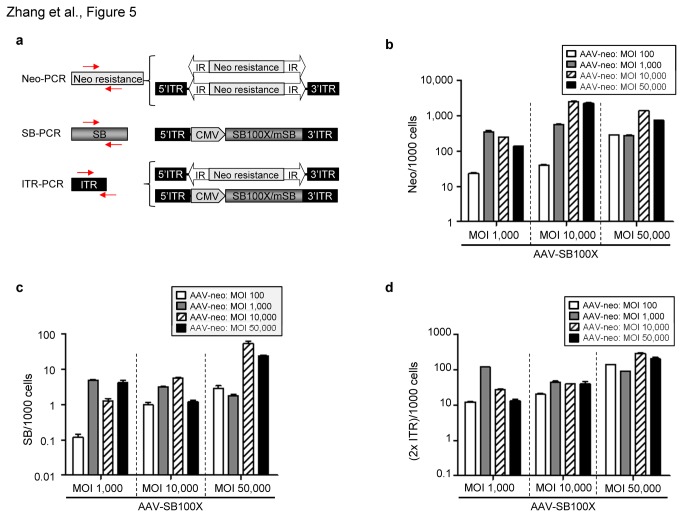
Genome copy numbers of each hybrid-vector element after AAV transduction.Genomic DNA of neomycin-resistant cells (from Figure 4) was analysed by quantitative real-time PCR (qRT-PCR) using primers and probe detecting AAV-ITRs and primers detecting the cDNAs of the two main functional genes neo (neomycin resistance gene) and SB (Sleeping Beauty transposase encoding gene). As internal control a PCR detecting hB2M (Beta-2-microgloblin gene) was performed.(a) PCR setup and location of primers used for quantitative analysis of vector genome copy numbers. The neo-PCR detects a 337 bp region in the neomycin resistance gene, which include integrated transposon, non- integrated and integrated AAV genomes. The SB-PCR detects an 82 bp region contained in the SB transposase encoding gene. Primers and probe specifically detecting the AAV ITR region [44] were used for amplification and detection of a 62 bp PCR product. Red arrows depict real-time PCR primer binding sites.(b) Neomycin copy numbers per 1000 cells after AAV transduction. Error bars indicate standard deviation (n=3).(c) SB transposase copy numbers per 1000 cells. Error bars indicate standard deviation (n=3).(d) 2XITR copy numbers per 1000 cells in co-transduced cells. Error bars indicate standard deviation (n=3).